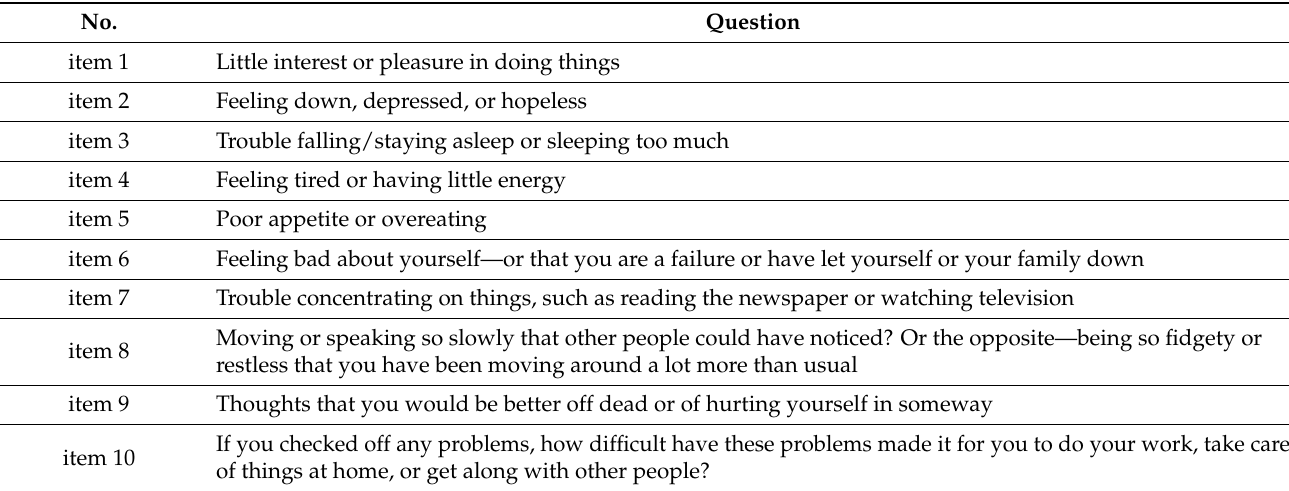
Figure A1. Independent variable inputted according to PHQ combinations. Table A1. PHQ-9 items.